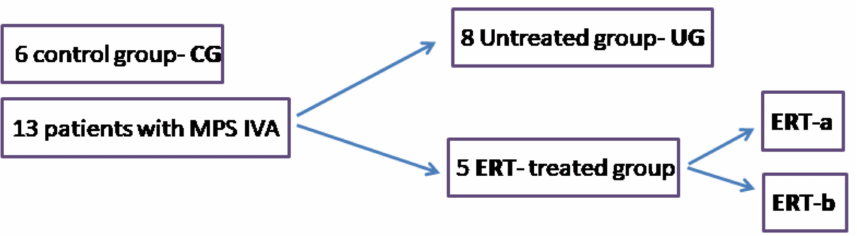
Figure 1. Study groups: controls and MPS IVA patients.CG, control group; MPS IVA, mucopolysac- charidosis type IVA; ERT-a, MPS IVA patients sampled before ERT; ERT-b, MPS IVA patients sampled 24 h after ERT.